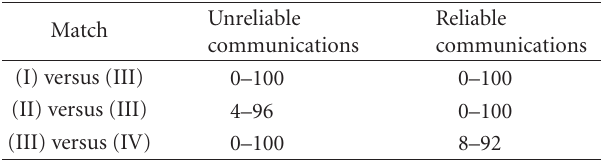
Table 3: Deathmatch of strategies: matches won (%) with reliable and unreliable